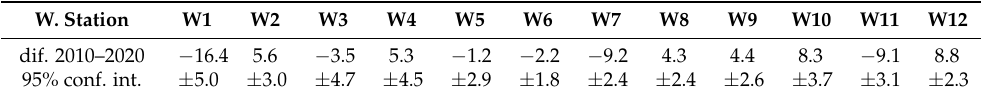
Table 6. Empirical coefficient of Hargreaves HC for each interval (Jan, Feb, Mar, etc.) multiplied by 10-3, adapted to the investigated weather stations (W1, W2, …) in order to minimize the difference between the HS ET0 equation and that of PM.